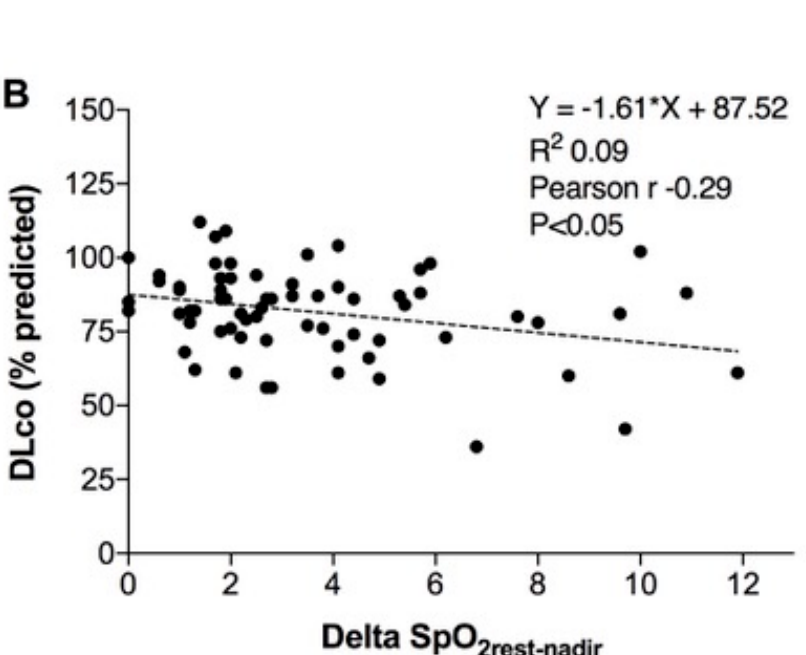
Figure 2. Correlation between the DLco and the DDR ( A ) and correlation between the DLco and SpO 2rest-nadir ( B ). DLco–SB: diffusing lung capacity for carbon monoxide; DDR: distance desaturation ratio; SpO 2 : Peripheral saturation of